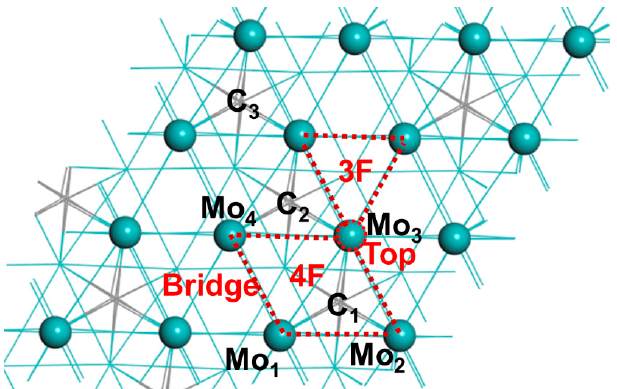
Figure 1. Position of the selected adsorption sites for alkali metal atoms. Color codes: Mo—green, carbon—grey, the first surface layer is shown using the ball and stick model, and the last five layers are shown using the line model.